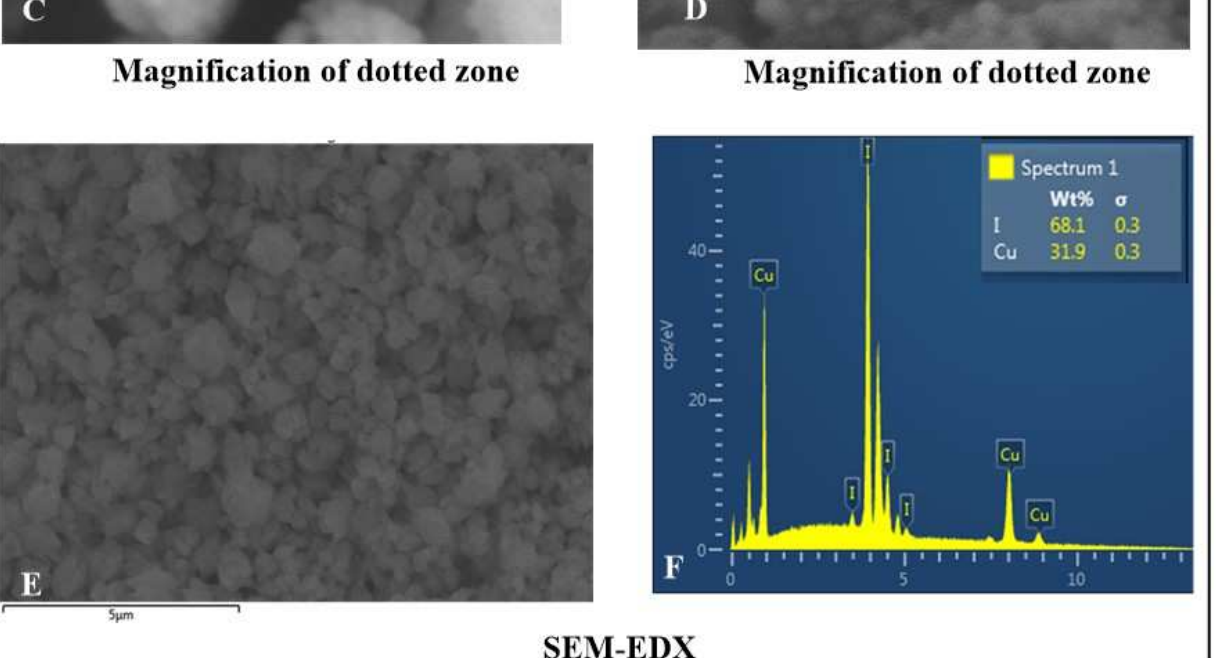
Figure 3. SEM-EDX analysis of CuI powdered nano-structured materials. ( A ) low magnification SEM micrograph of CuI powdered material, the shell like morphology of the materials is easily seen. ( B ) high magnification SEM micrograph of CuI powdered material, illustrating the ordered nanostructures that compose the 3D shell microstructures. ( C ) magnification of dotted zone in A. ( D ) magnification of dotted zone in B. ( E ) SEM micrograph for EDX analysis. ( F ) EDX analysis of CuI powdered